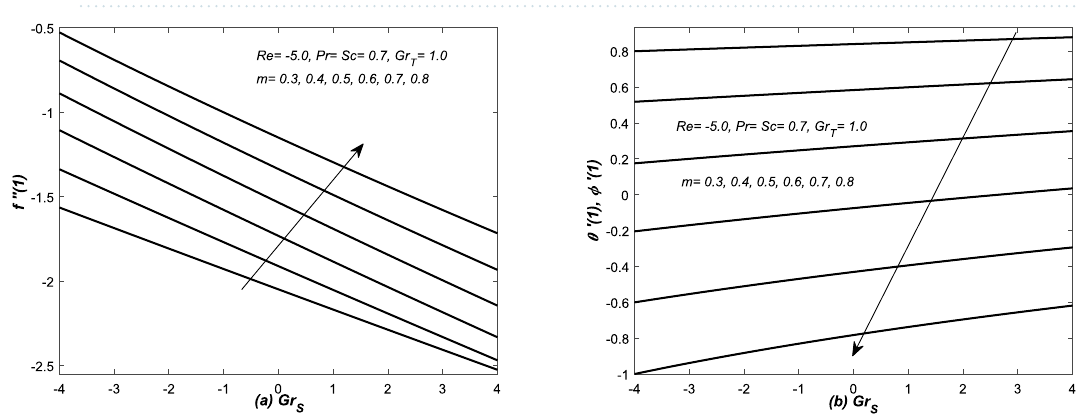
Figure 13. ( a ) Skin friction coefficient f ′′ ( 1 ) and ( b ) heat and mass transfer coefficients are plotted against Reynolds number Re for assisting flow, whereas, different values are assigned to the slope m .